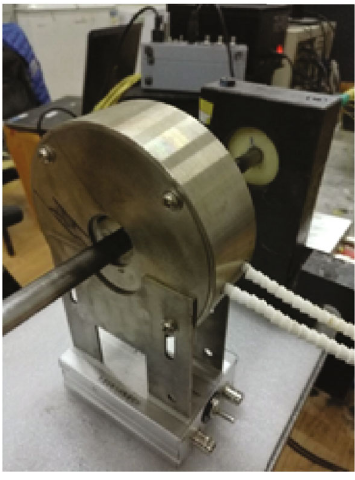
Figure 10: Heating